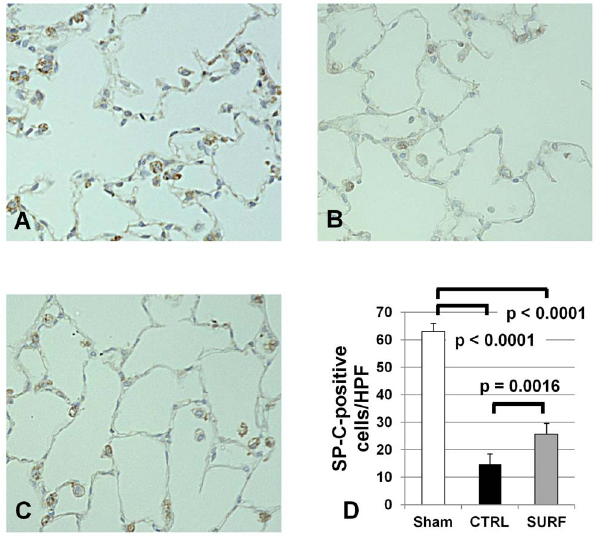
Figure 9. Immunohistochemical staining for SP-C (original magnification 400 6 ). (A) Sham group. (B) CTRL group. (C) SURF group. The amount of SP-C-positive cells in the CTRL and SURF groups was significantly lower than that in the Sham group, however, that in the SURF group was significantly higher than that in the CTRL group (D). All values are expressed as the mean 6 SD.